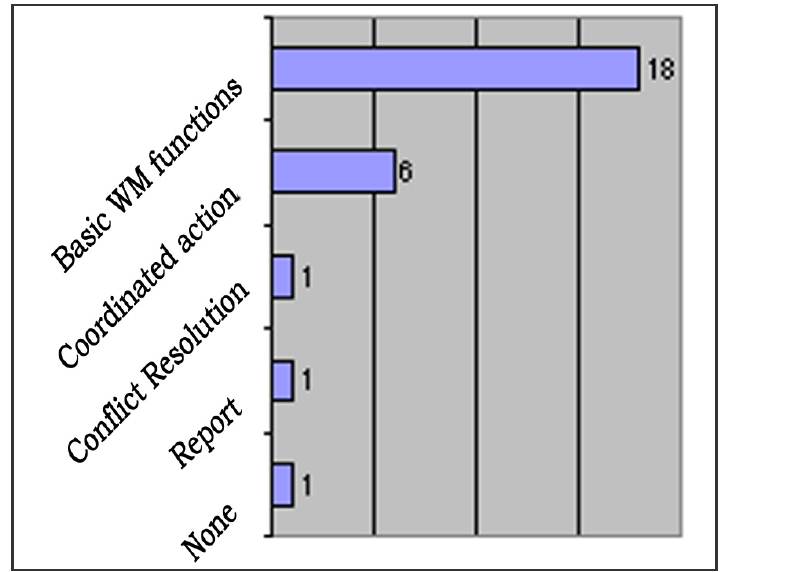
Figure 3 Expected functions of a local WM institution (nb